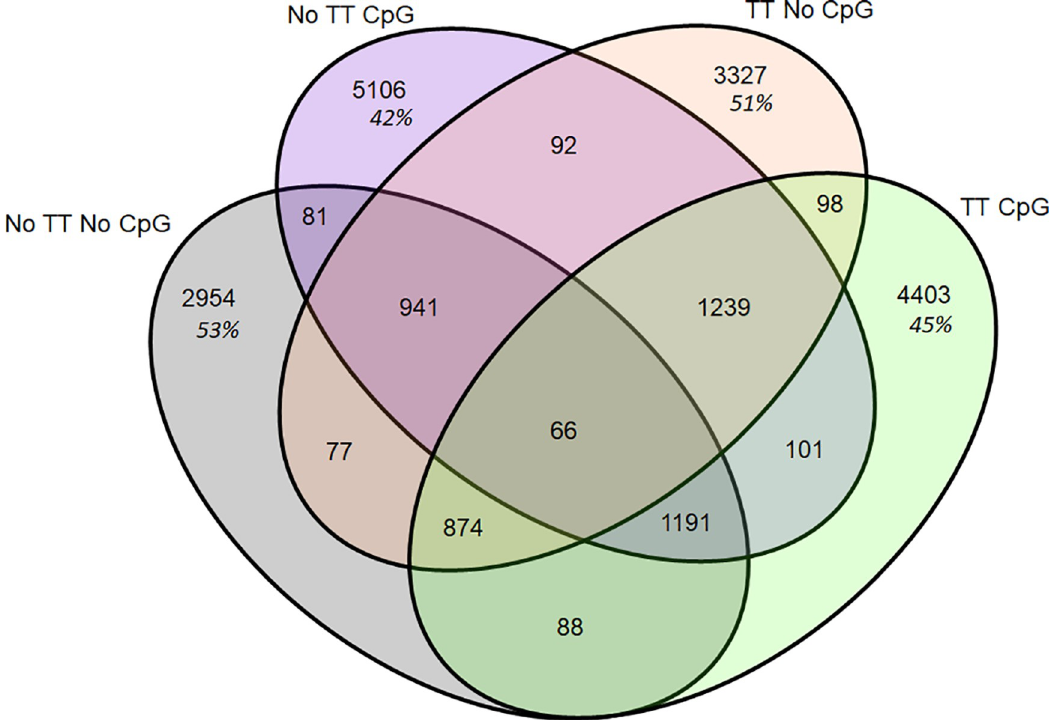
Fig 15. Unique CDR3 amino acid sequence overlap for TT and CpG treatment groups for class-switched antibodies. The overlap of unique CDR3 amino acid sequences is displayed in Venn Diagrams. The total number of unique CDR3 amino acid sequences in each treatment group, regardless of AOS status, with the percent of the shared repertoire shown in italics below the number of unique amino acid sequences.